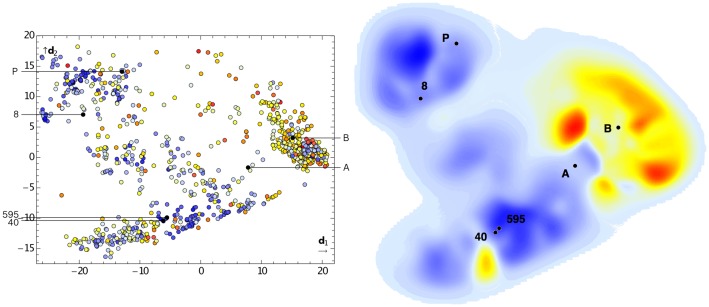
Projection of MD conformations of Archazolid A onto two dimensions (, ) by principal component analysis.Shown are distribution of individual conformations (left) and smoothed energy landscape generated by LiSARD [52] (right). Labels indicate reported NMR-motivated structures (A = c5a, B = c5b, P = nmr) and lowest-energy MD conformations (8, 595, 40). Color coding is from lowest (blue) to highest (red) relative energy.